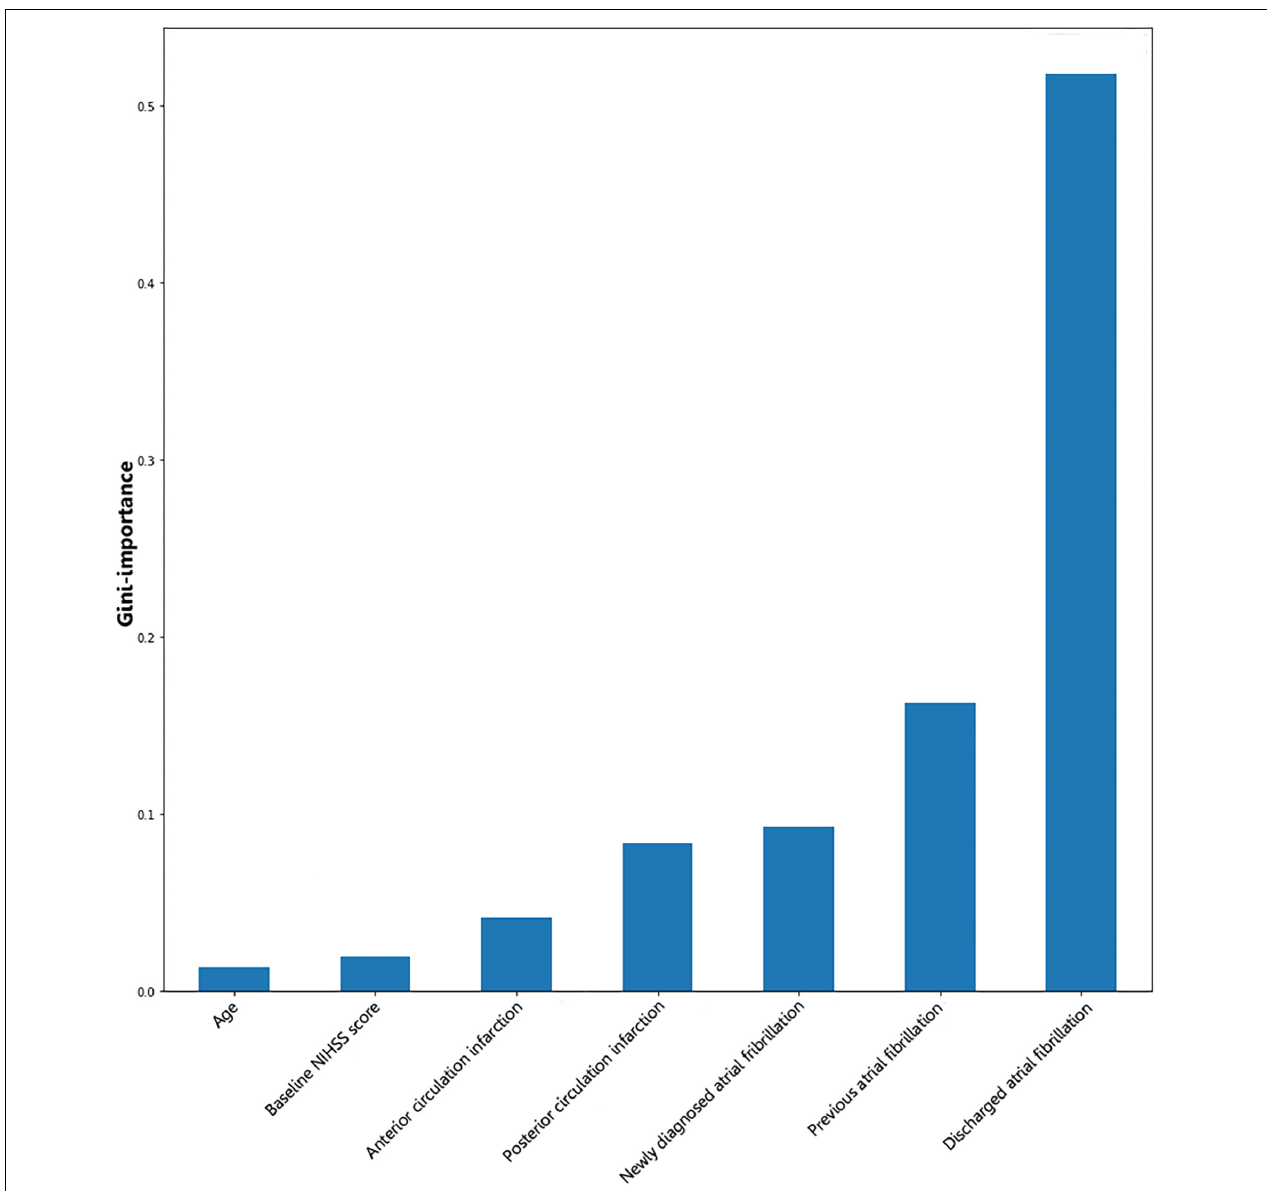
FIGURE 1 | Illustration of features contributing to the identification of CE by Gini importance values. CE, cardioembolism; NIHSS, National Institutes of Health Stroke Scale. Gini importance is a measurement of the feature importance in the model; the higher the value of Gini importance is, the more important the feature